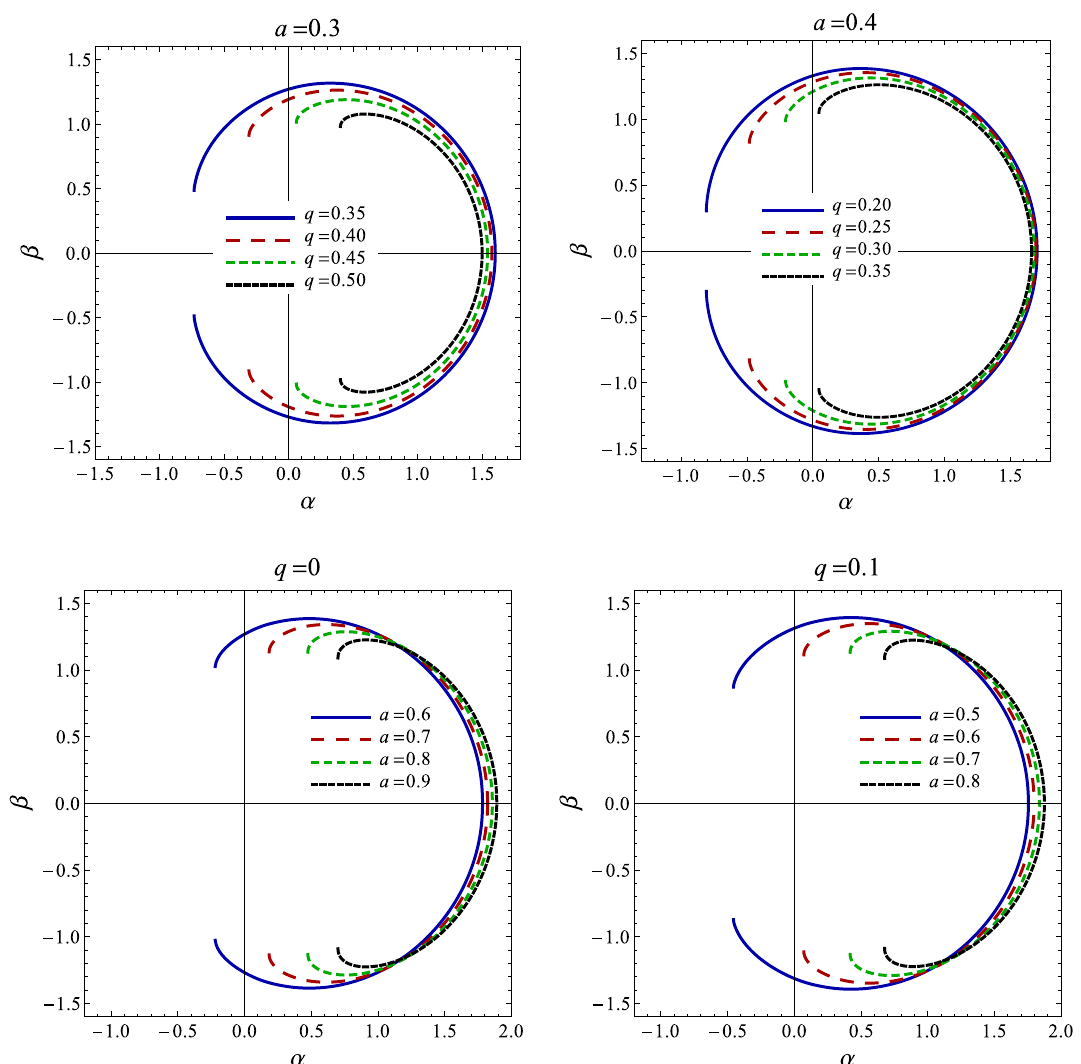
Fig. 8 Shadow cast by the naked singularity with inclination angle θ 0 = π/ 2 for different values of the charge q and the spin a . Here Myers–Perry black hole ( q = 0) case is included for